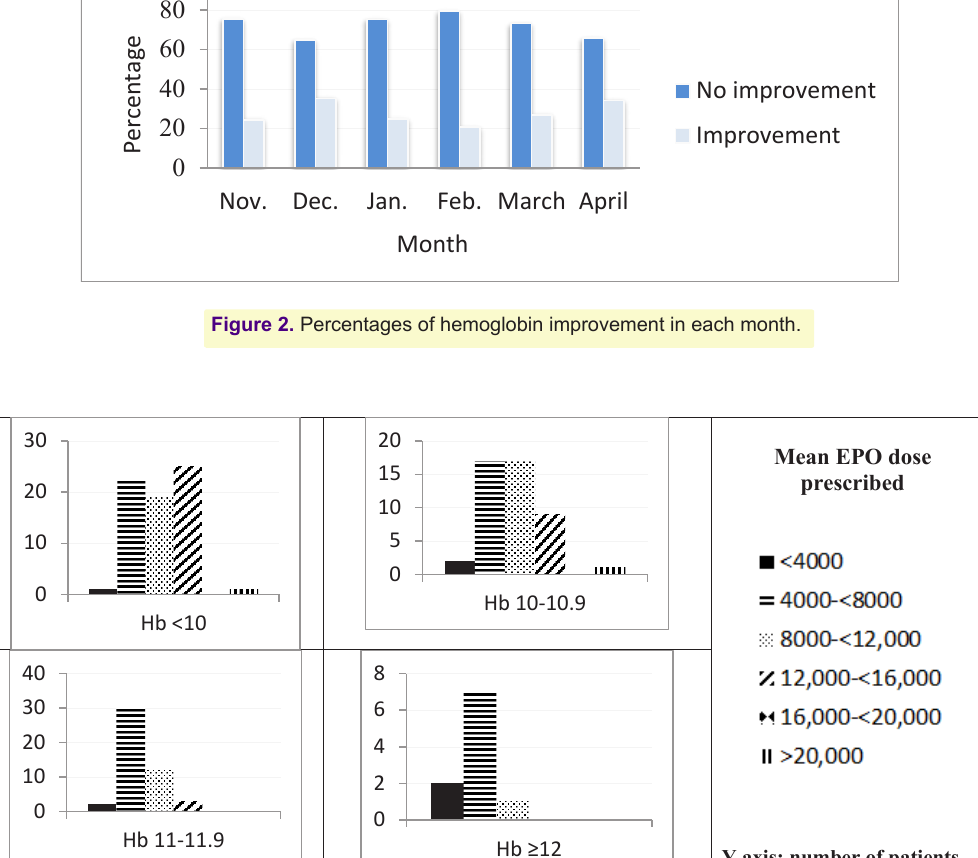
Y axis: number of patients Figure 3: Relation between Mean EPO Dose Prescribed (IU/WK) and Hemoglobin Figure 3. Relation between mean EPO dose prescribed (IU/wk) and Hb level.